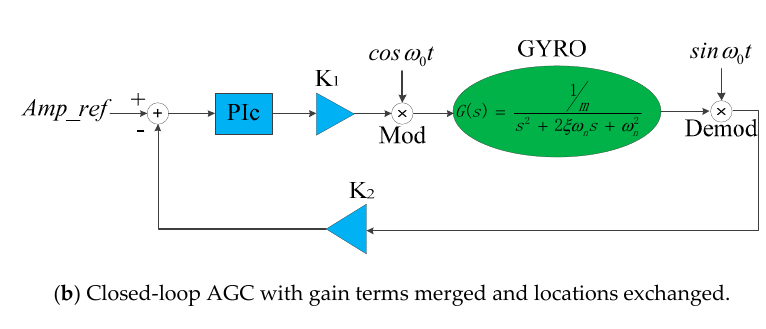
Figure 5. Simplification process of closed-loop